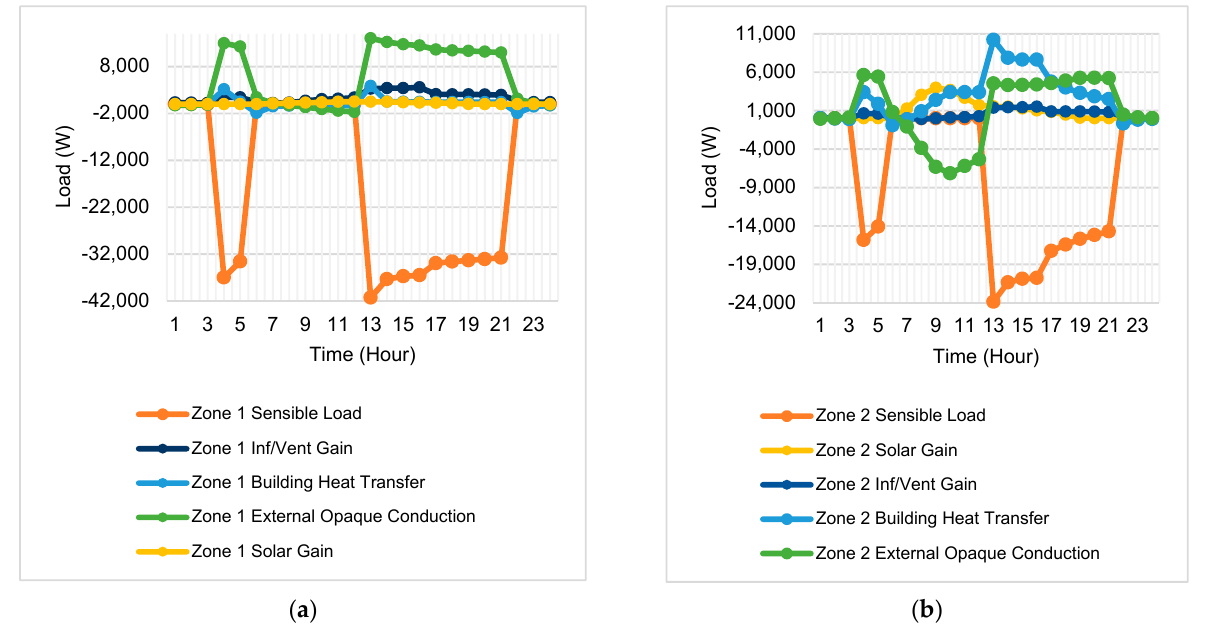
Figure 17. ( a ) Loads breakdown in Al Wafi mosque (Zone 1) during day 179 (summer); ( b ) loads breakdown in Al Wafi mosque (Zone 2) during day 179 (summer).